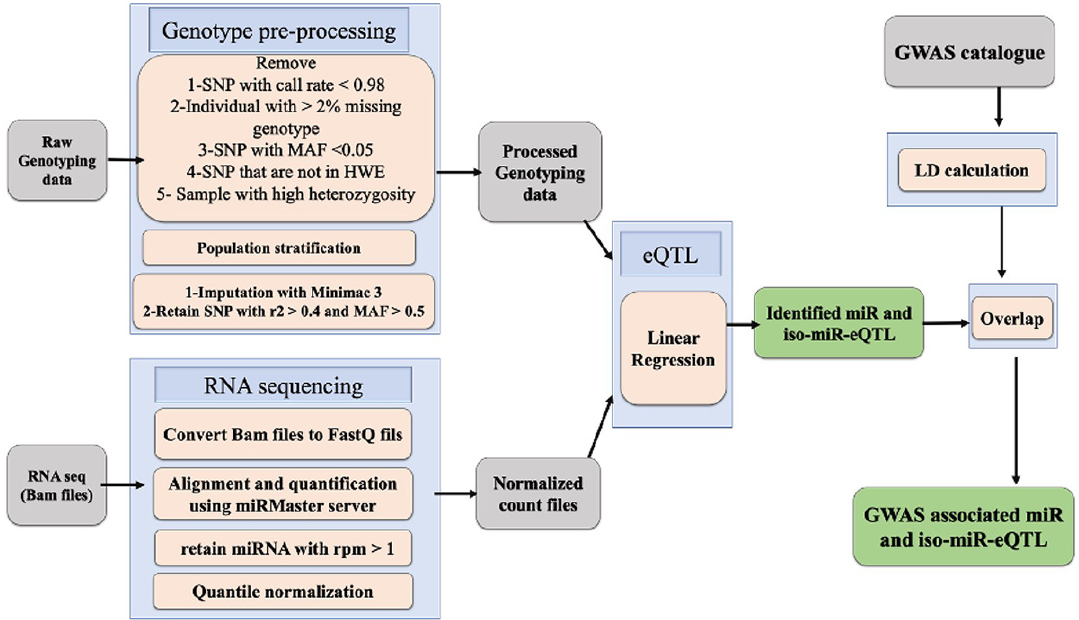
Figure 1. The pipeline of the miRNA and isomiR-eQTL analysis. The grey boxes show the type of data, the blue boxes show the methods of analysis, and the green boxes show the results of this analysis. Table 1. The number of European samples in each type of cancer in this study. Data for each cancer type were downloaded from (TCGA) (tumour tissue only), where data for genotype and small- RNA-seq was available. The samples of non-European populations were excluded via principal components analysis.